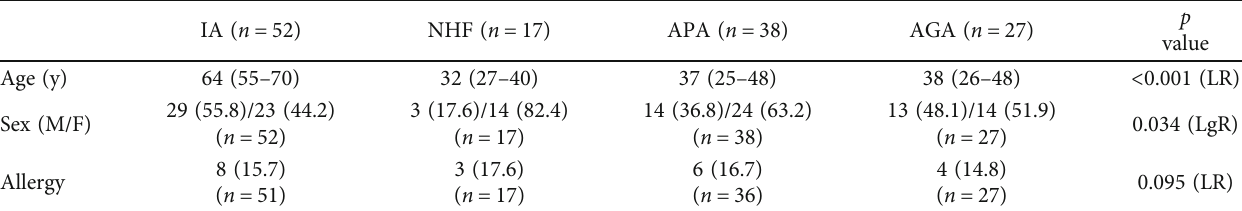
Figure 1: Light microscopy evaluation. Table 1: Appendicular specimen ’ s